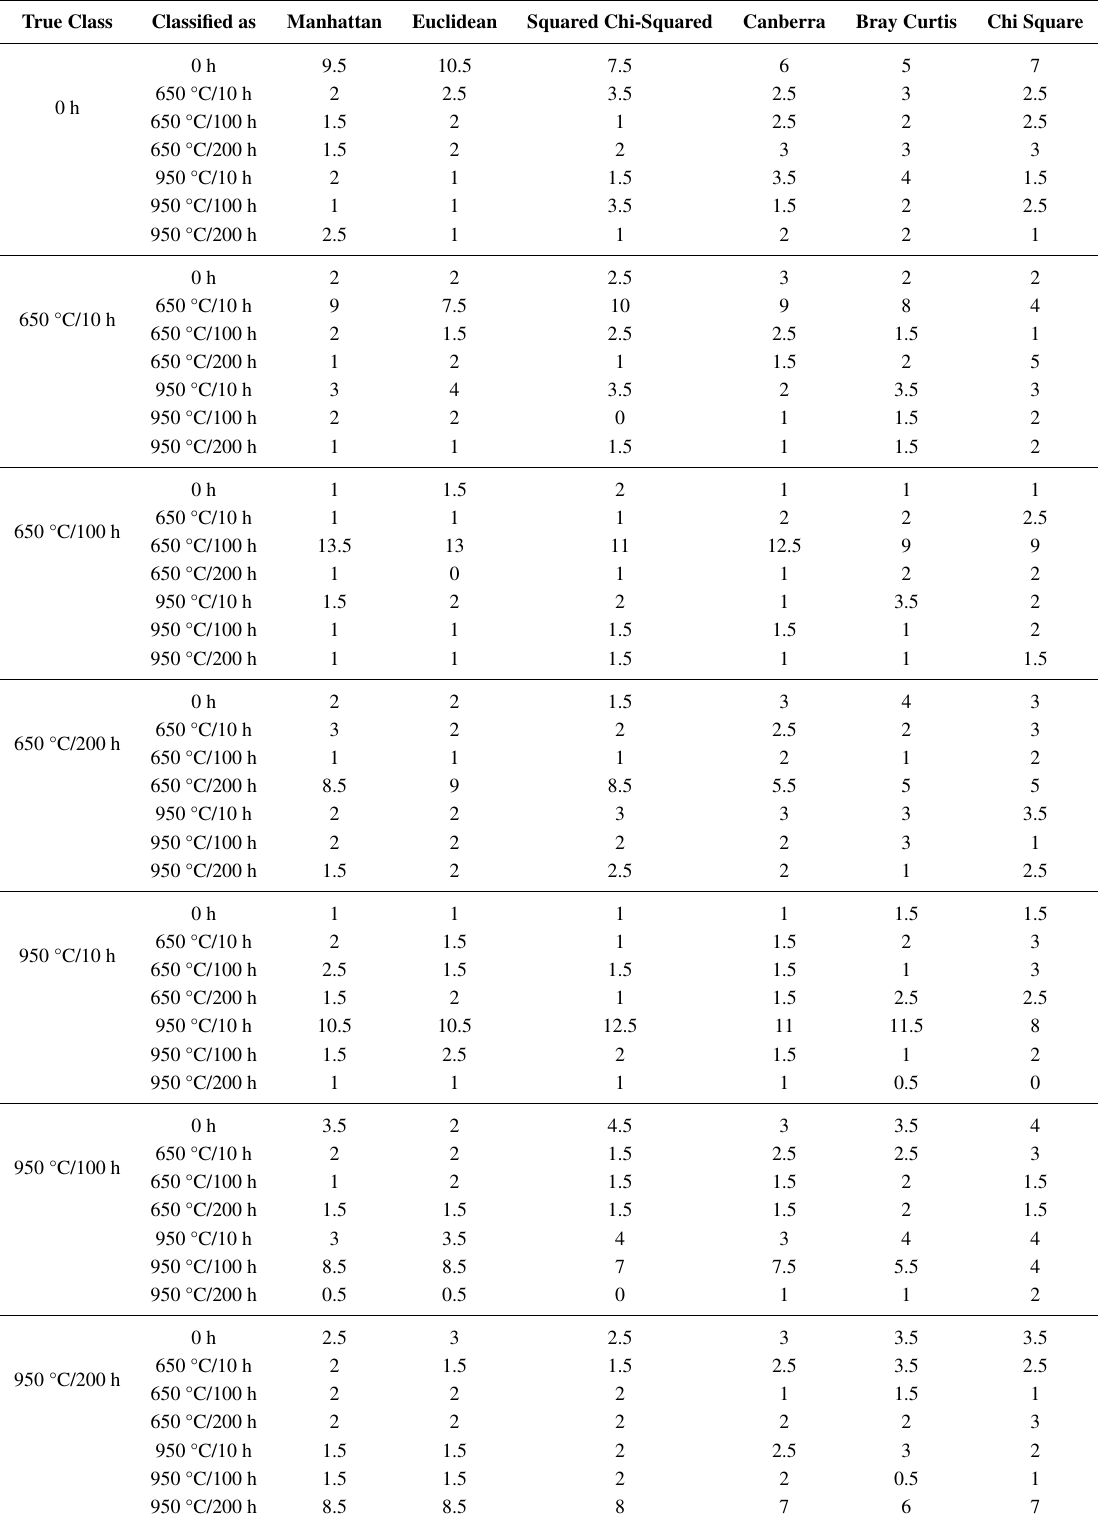
Table 16. Confusion matrix of the classification means for the 4-MHz frequency pulse echo signals at 650 and 950